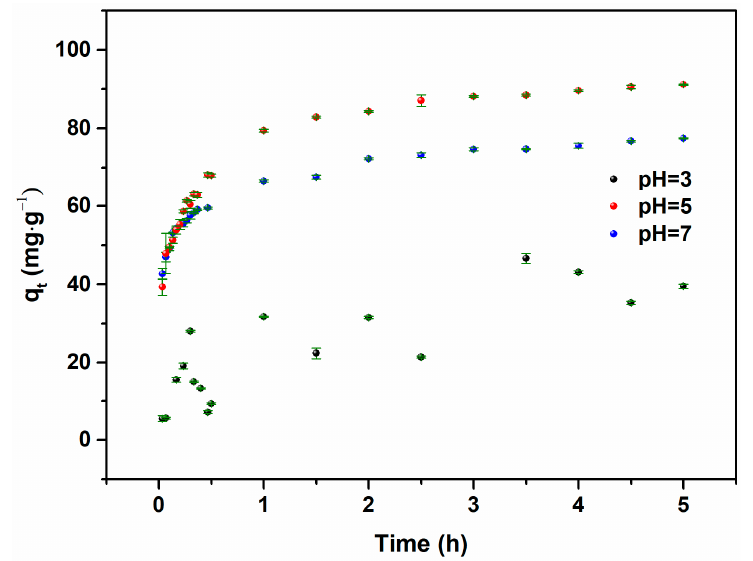
Figure 2. E ff ect of pH values on the adsorption capacity of Hg 2 + ions via OS / Fe 3 O 4 / HA (initial Hg(II) Figure 2. Effect of pH values on the adsorption capacity of Hg 2+ ions via OS/Fe 3 O 4 /HA (initial Hg(II) ion concentration, 25 mg · L − 1 , contact time, 5 ion concentration, 25 mg·L − 1 , contact time, 5 h).